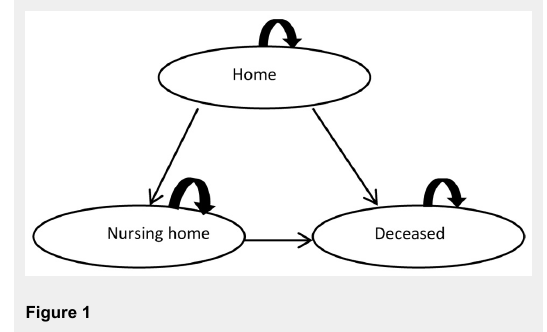
Structure of the Markov model from Lachaine et al.